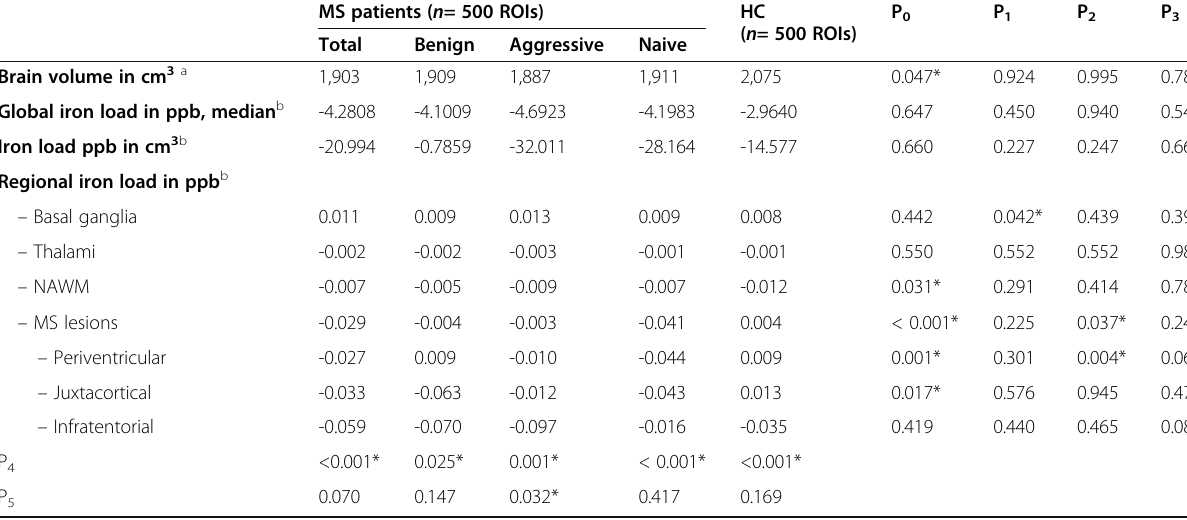
Table 2 Brain global and regional iron concentrations in the studied